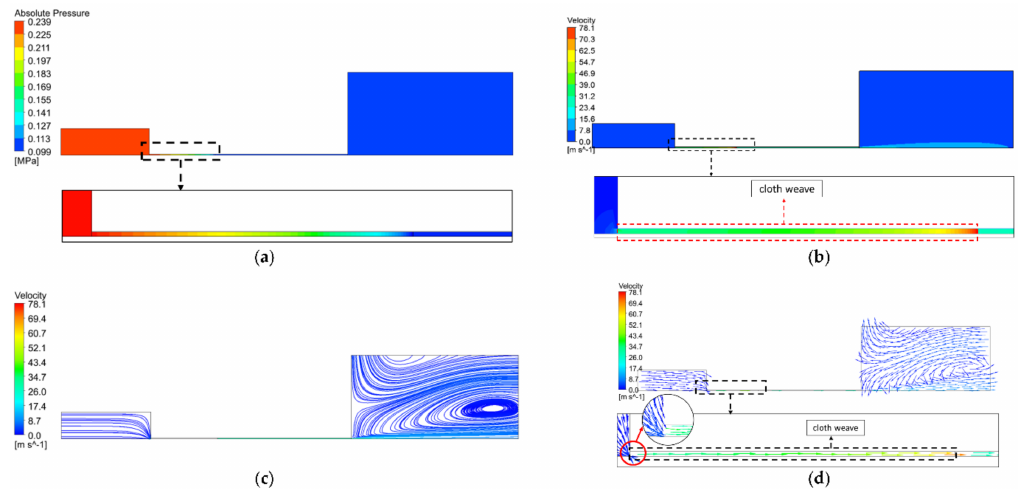
Figure 15. CFD results for shute direction ( C down = 0.9, ∆ P = 137.9 kPad): ( a ) pressure contours,